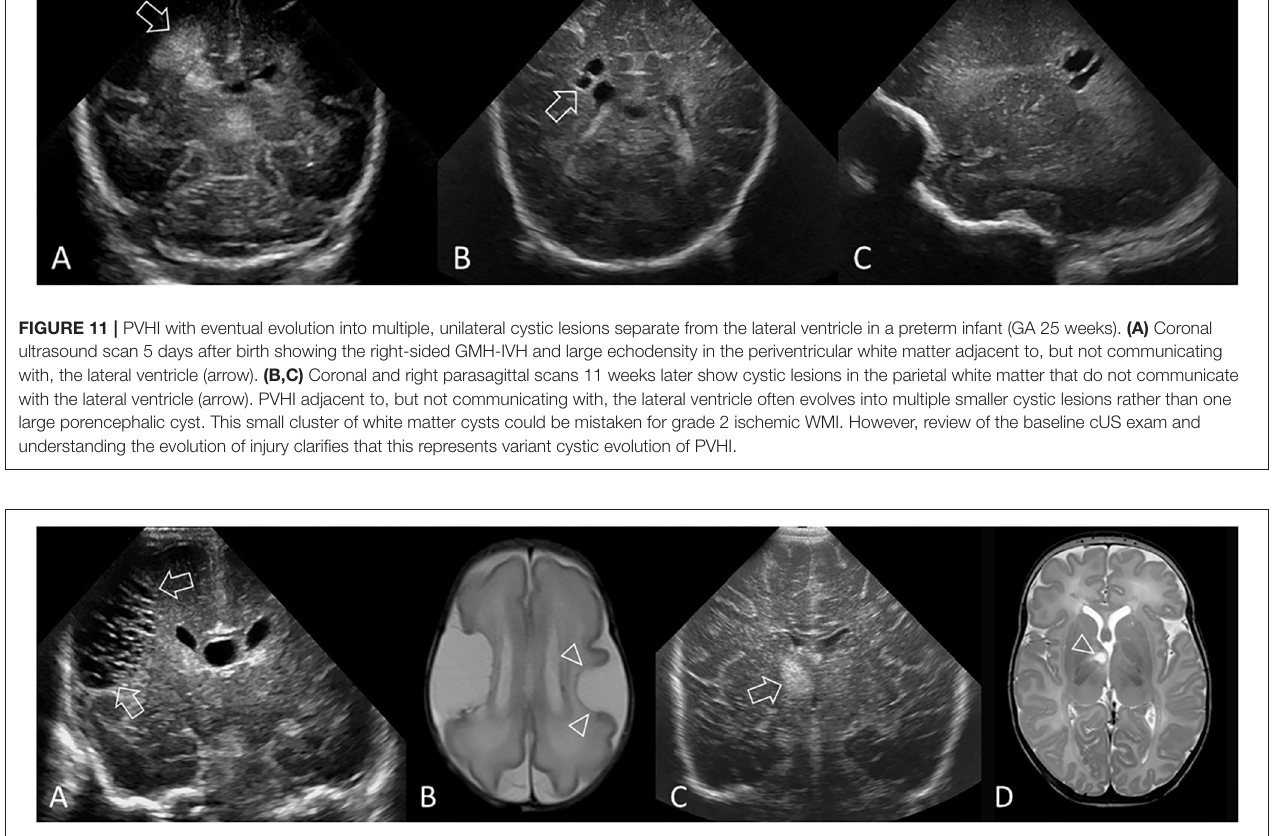
FIGURE 12 | Other forms of acute injury. (A,B) Preterm infant (GA 27 weeks) with bilateral middle cerebral artery (MCA) territory infarction. (A) Coronal ultrasound scan 3 weeks after birth shows extensive cystic injury in the right frontoparietal region (arrows), but located more lateral than expected for common periventricular WMI. Focal echodensity was first identified at this location on cUS 7 days after birth (not shown). (B) Axial T2-weighted MR image shows the large right MCA cortical infarct and an additional smaller left MCA cortical infarct (arrowheads) that was not readily appreciated on cUS because of its far lateral location. The bilateral MCA strokes suggest a proximal embolic source, and placenta was suspected. (C,D) Perforator stroke in a preterm infant (GA 34 weeks). (C) Coronal ultrasound scan, at the level of the third ventricle and foramen of Monro, performed after surgery for ventriculoseptal defect closure shows a focal echodensity in the medial right capsuloganglionic region (arrow). cUS performed prior to surgery did not show any abnormality. Findings are most consistent with lenticulostriate territory infarction (middle cerebral artery perforating branches). (D) Axial T2-weighted MR image after 2 weeks shows cystic evolution of the infarct without evidence of previous hemorrhage